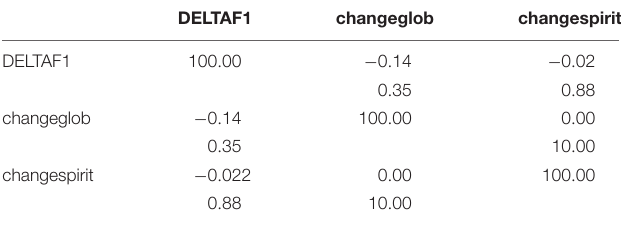
TABLE 7 | Pearson correlation coefficients relative to main principal components of IES, Thermometer and PTGI.